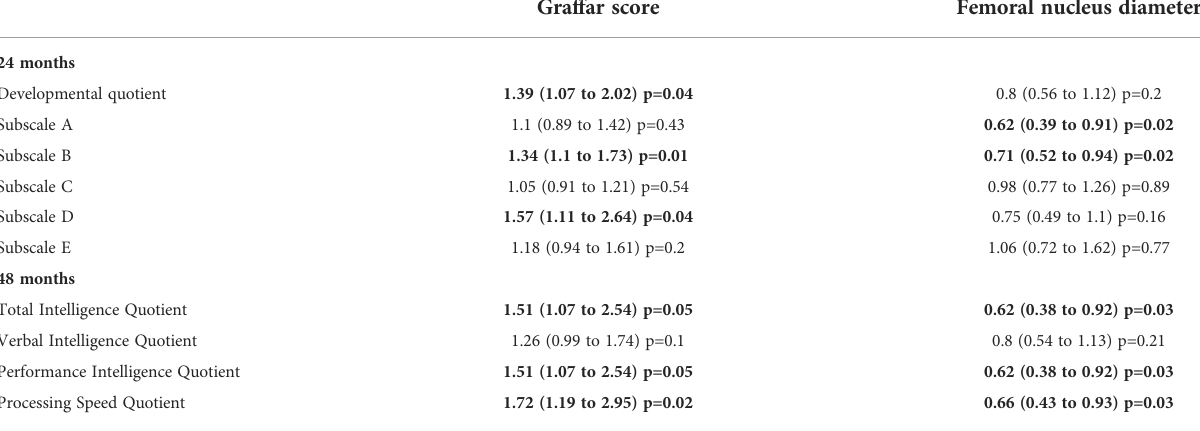
TABLE 3 Impact of Graffar score and femoral nucleus diameter on long-term neurodevelopmental outcomes. Graffar score Femoral nucleus diameter